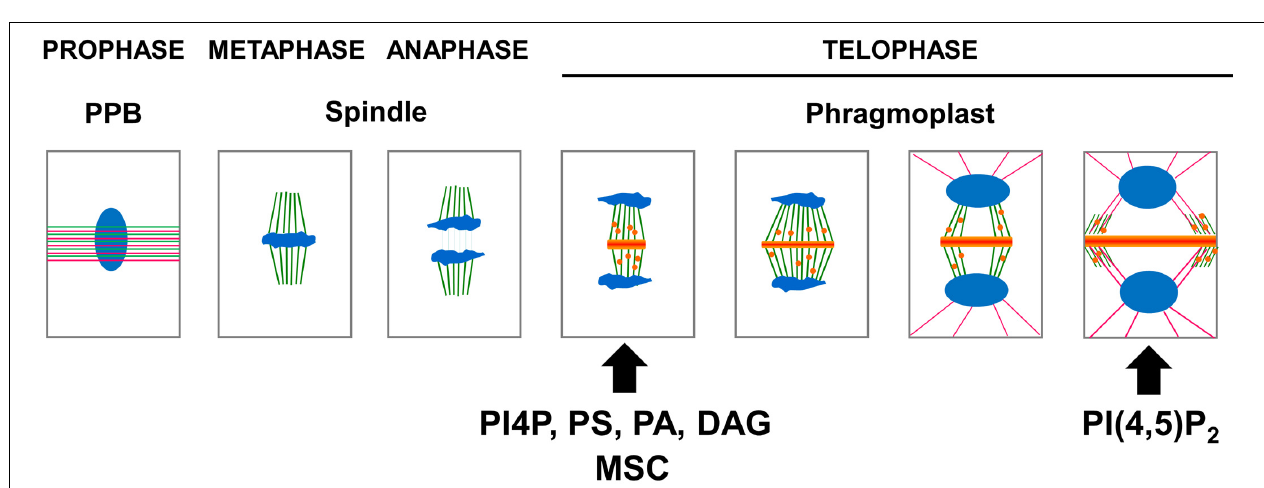
FIGURE 2 | Cartoon representing the step of cell division in plant. Central division zone (CDZ) in blue, Actin microfilaments (MF) in pink, nucleus in dark blue, growing cell plate in gray. Note that in prophase actin MF localizes at the CDZ while it is excluded shortly before metaphase (ADZ) when actin “twin peaks” can be observed (pink arrows). In anaphase/metaphase transition a strong actin MF signal is observed at the apical/basal region of the cells (arrowhead). At the end of the telophase the expanding cell plate will join the PM of the mother cell by excluding proteins from the CDZ and therefore forming the cell-plate fusion site (gray arrow).